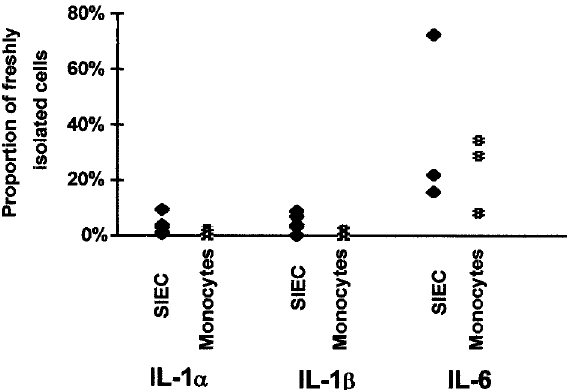
FIG. 2. Intracellular expression of IL-1 a ( n = 6), IL-1 b ( n = 6) and IL-6 ( n = 3) by SIEC freshly isolated from human duodenal biopsies. Results are expressed as percentages of SIEC expressing each cytokine, as assessed by flow cyto- metry, and are compared with those obtained for monocytes from the same